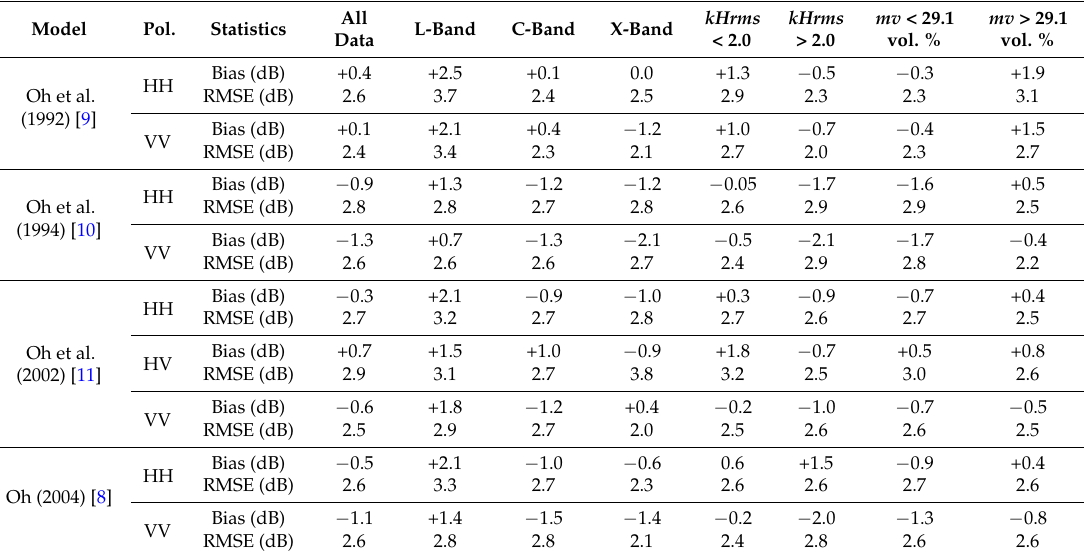
Table 3. Comparison between real data and Oh models for all data and different ranges of kHrms and soil moisture ( mv ). Bias = real data −